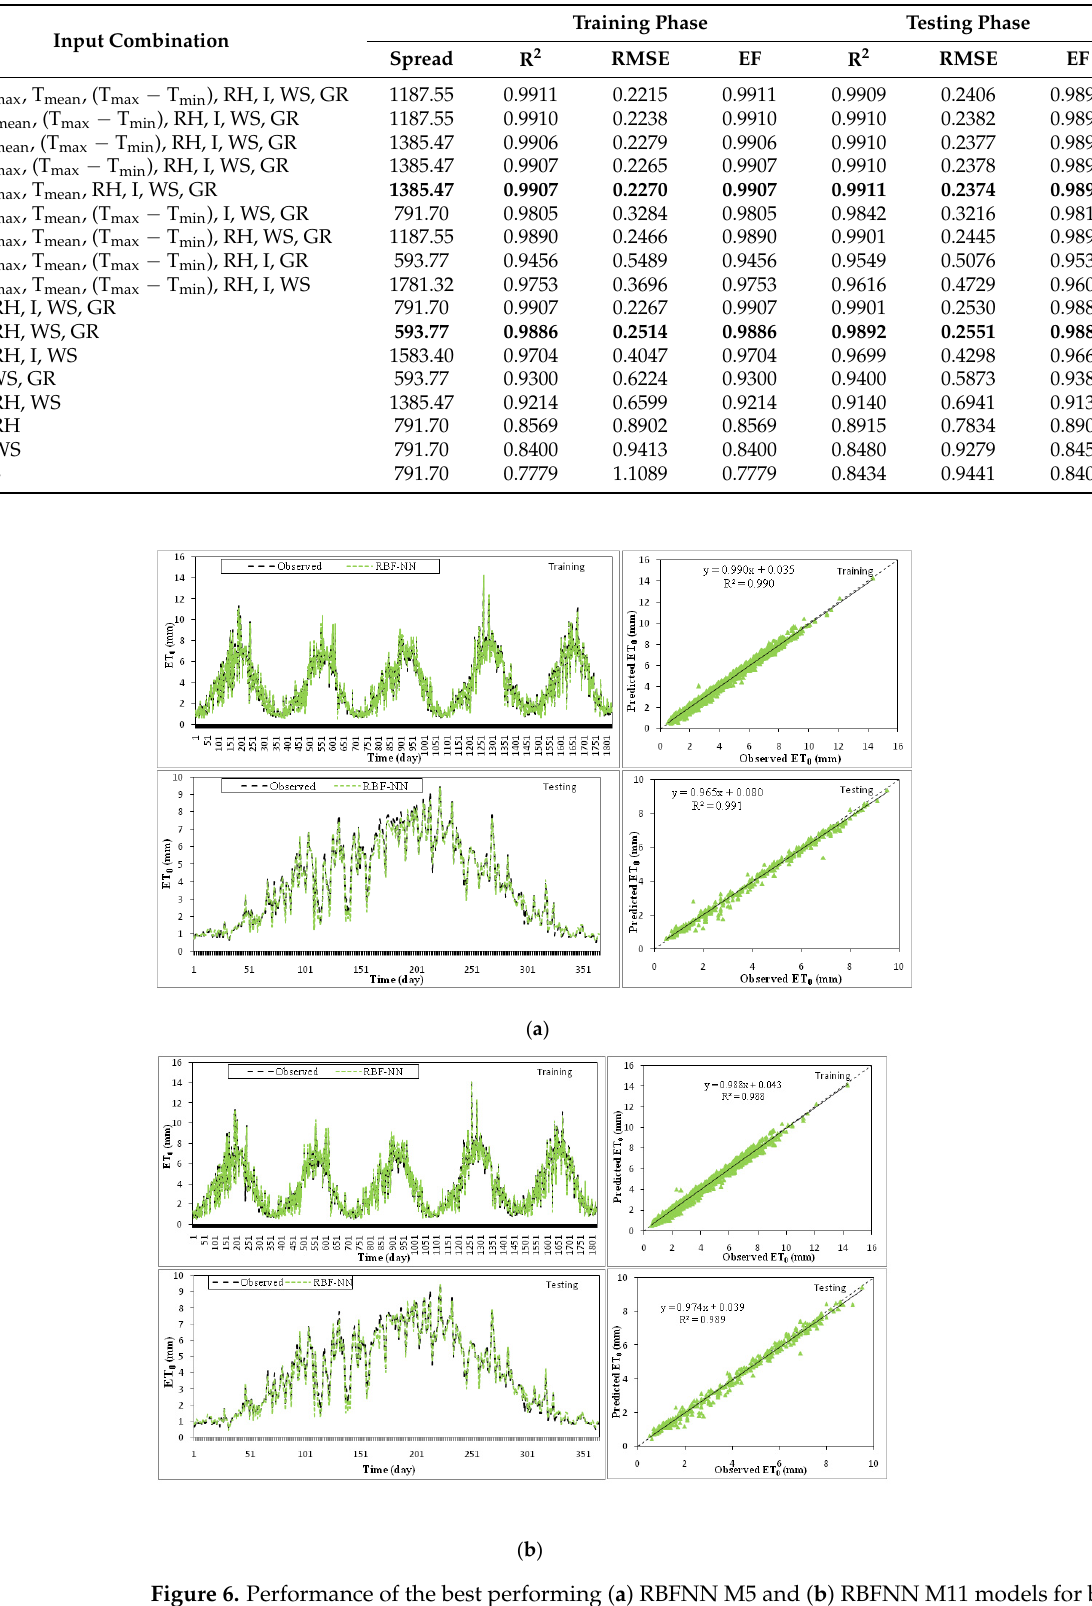
Table 5. Statistical criteria for an estimation of ET 0 using different input variables for RBF. The bold part shows that this model is superior to others.